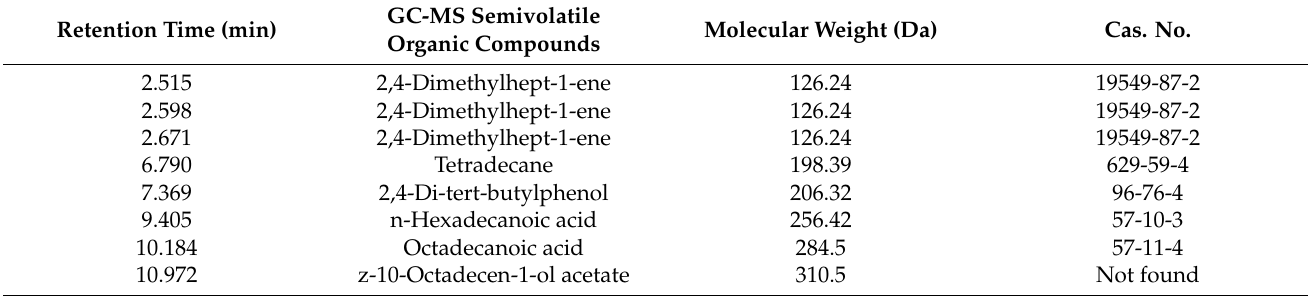
Table 6. Semivolatile organic compounds identified in